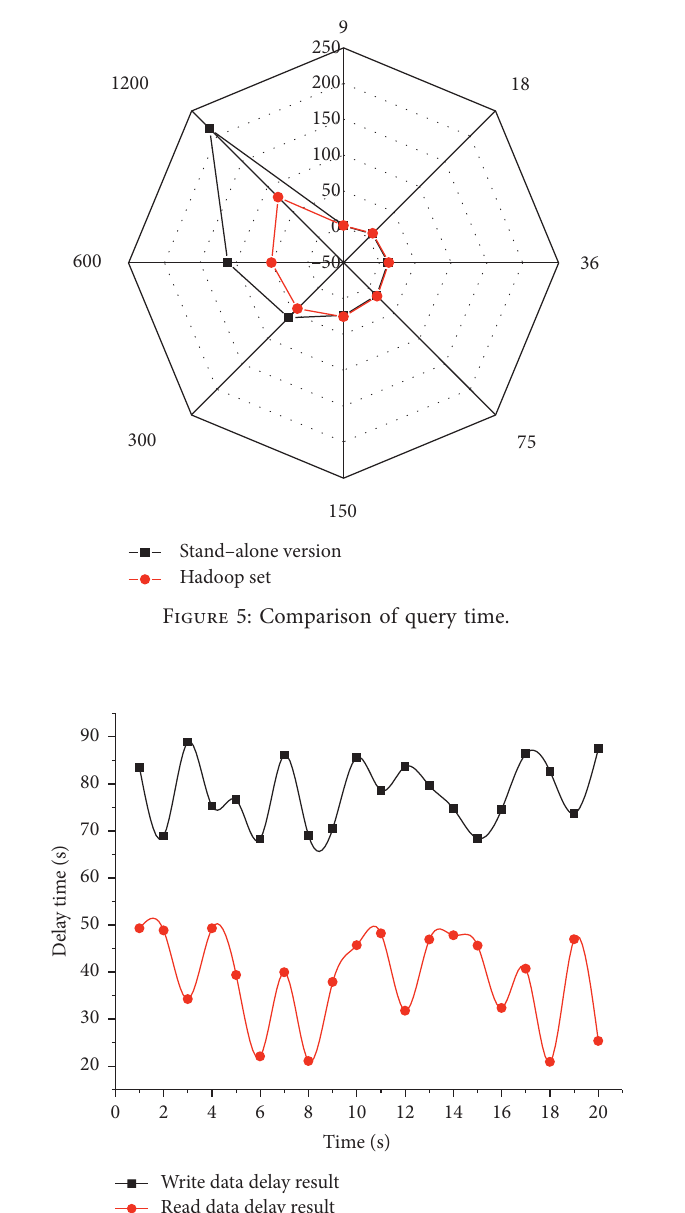
Figure 4: File distribution by node.